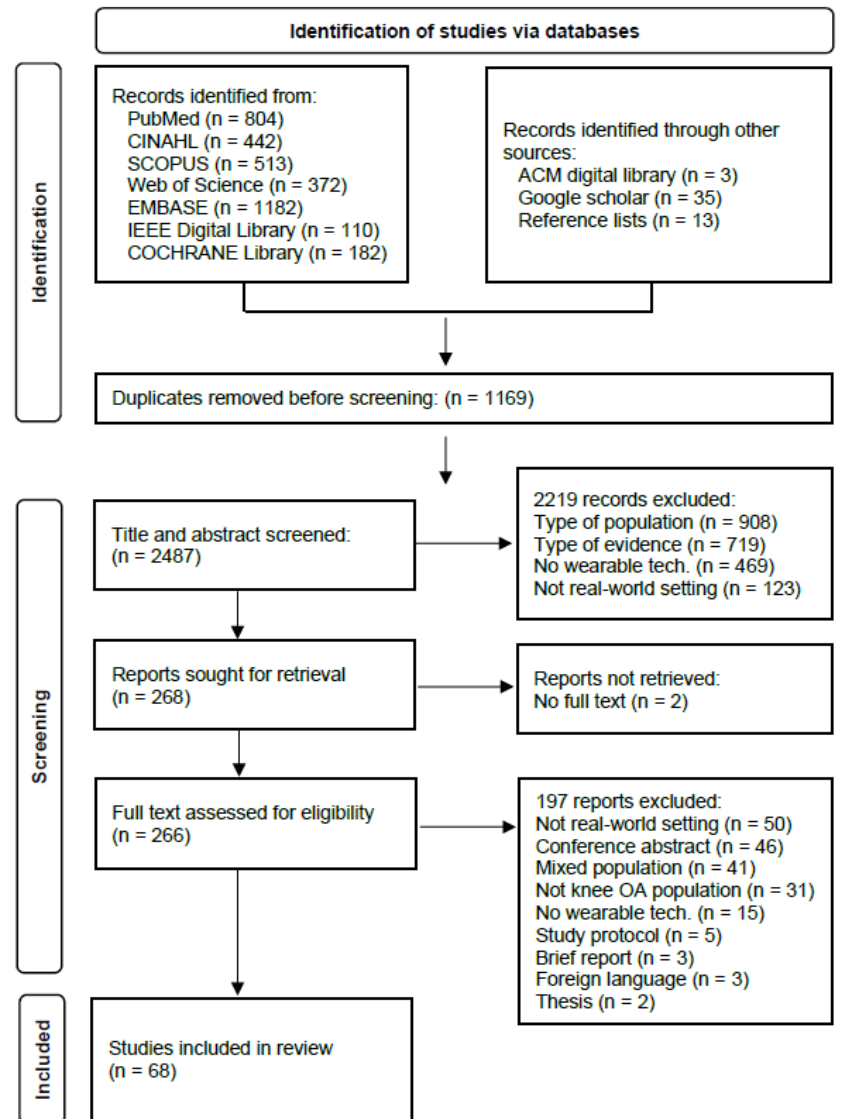
Figure 1. Flow diagram of the study selection process.